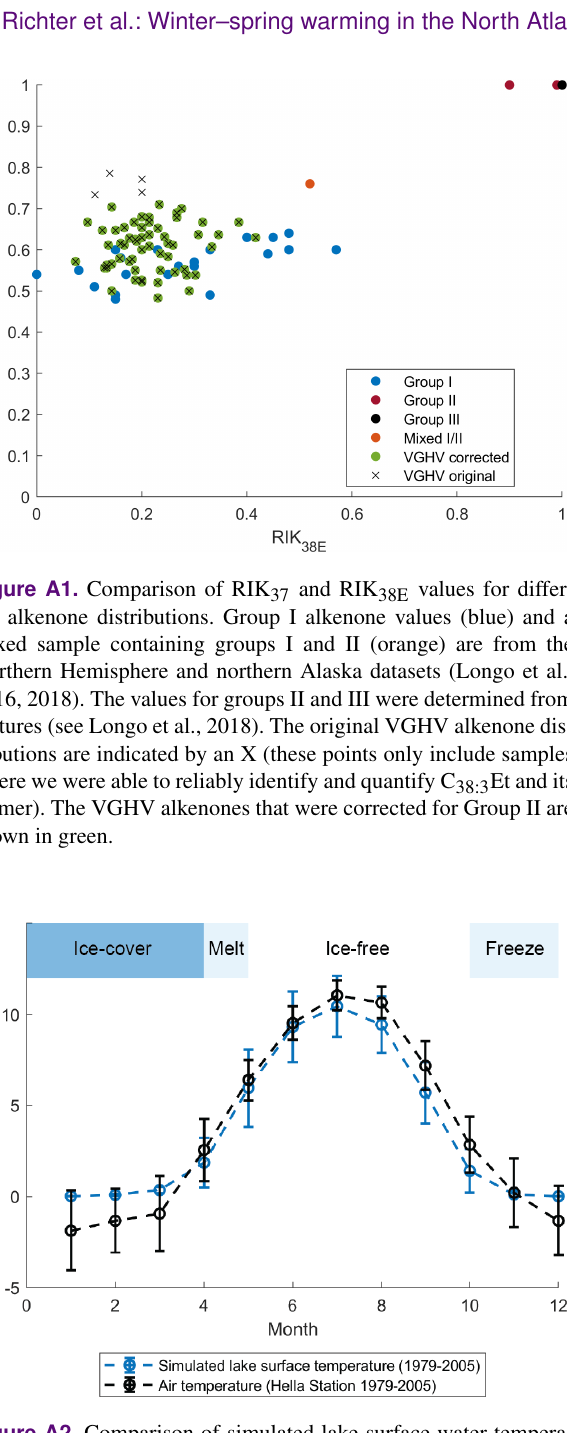
Figure A2. Comparison of simulated lake surface water tempera- tures for VGHV (blue) and air temperatures from a nearby meteo- rological station (Hella Station) for the period of 1979–2005. The average duration of ice cover simulated in our lake model is shown in dark blue. The average timing of ice-out dates and the timing of when lake ice cover starts to form that is simulated in our lake model are shown in pale blue.